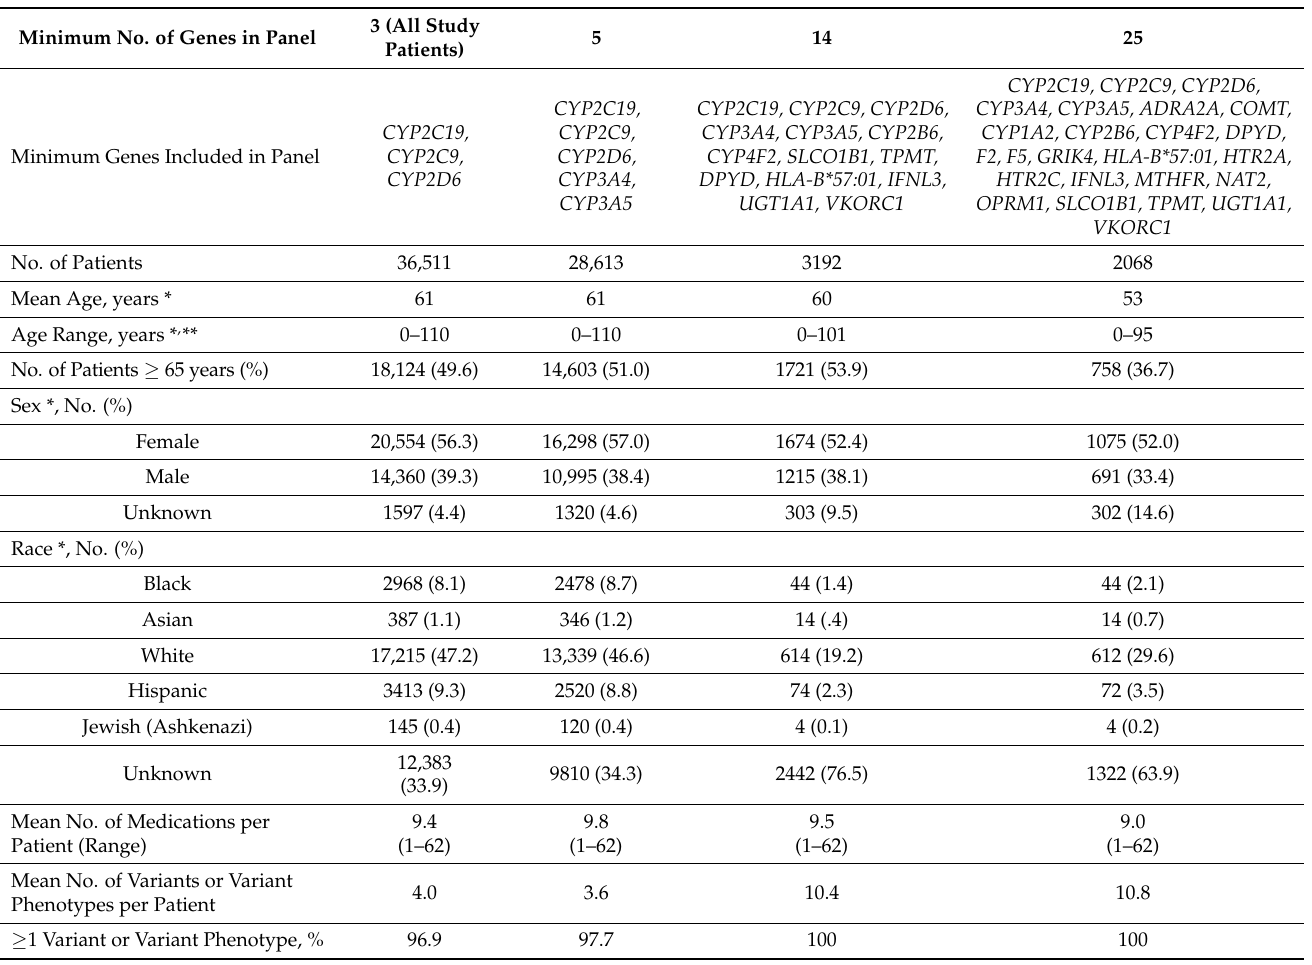
Table 1. Patient